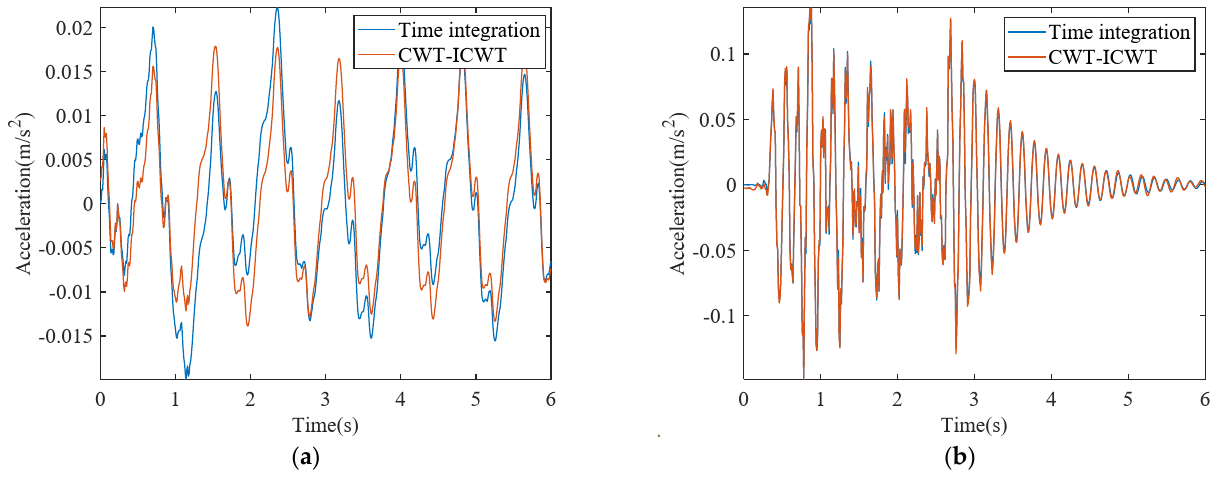
Figure 5. Comparison of response history between CWT–ICWT method and traditional time history integration method: ( a ) Response history of car body vertical acceleration; ( b ) Response history of bridge mid–span vertical acceleration.